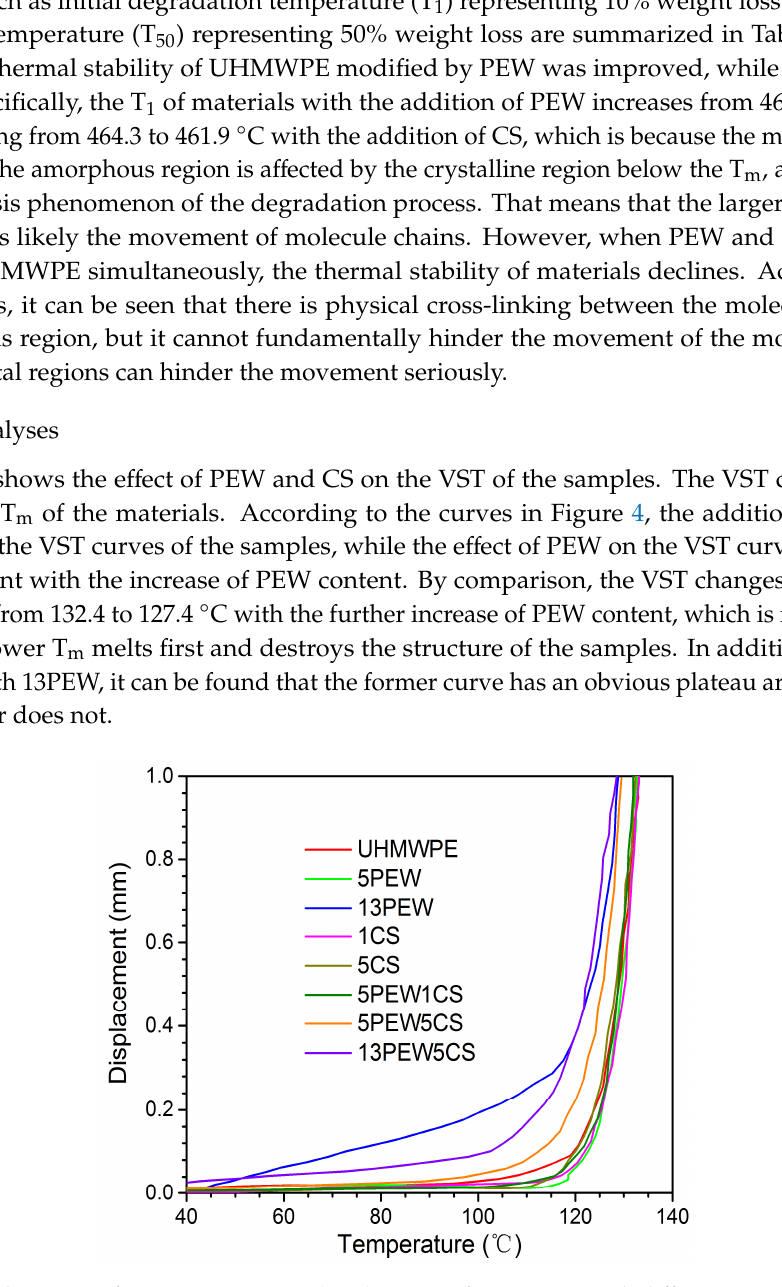
Figure 3. Thermal properties of UHMWPE with different contents of PEW and CS: ( a ) DSC curves; ( b ) TGA curves.